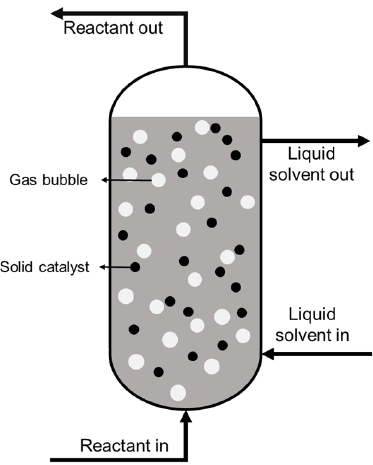
Figure 7. Illustration of three-phase slurry bubble column reactor.